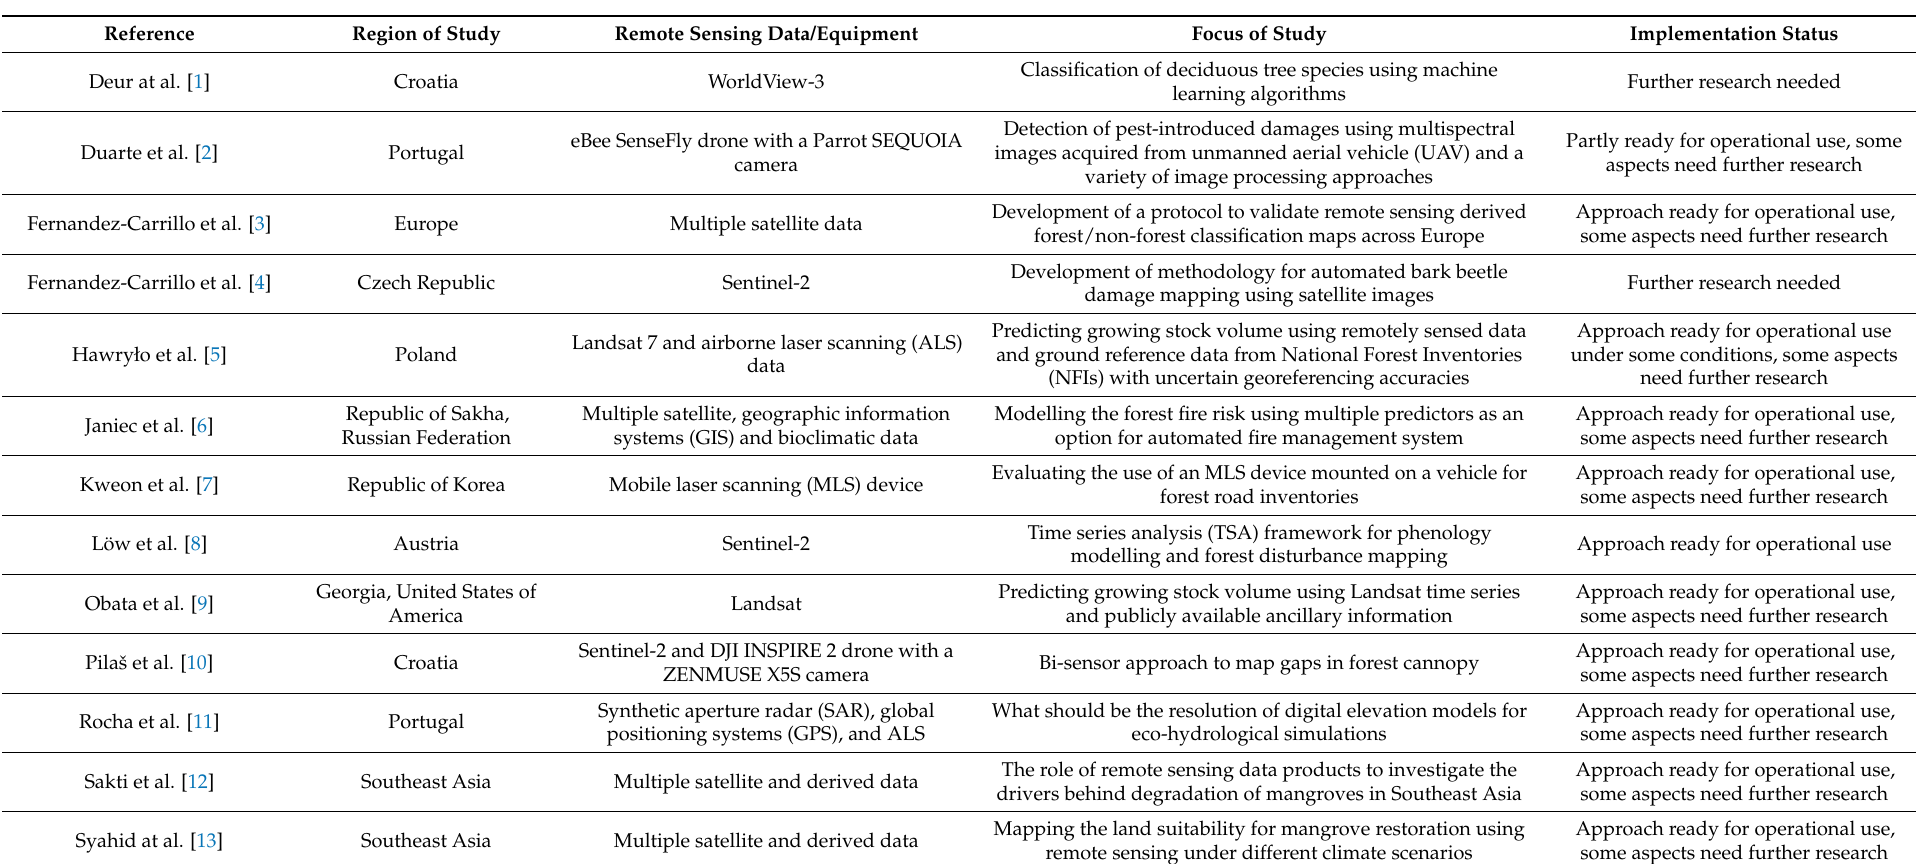
Table 1. Summarizing facts on the topics covered in the Remote Sensing Special Issue on “operationalization of remote sensing solutions for sustainable forest